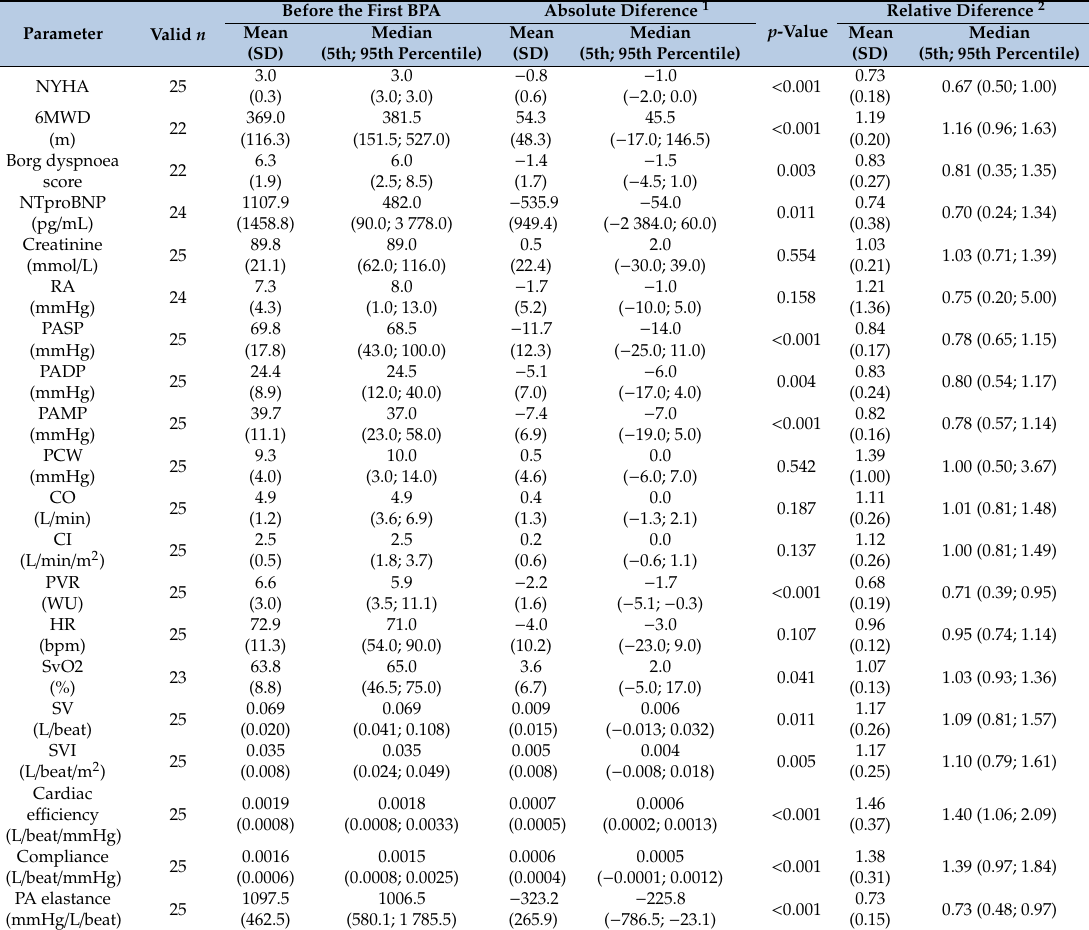
Table 2. Comparisons of clinical outcomes before the first and after the last BPA session in patients with completed BPA treatment ( n =